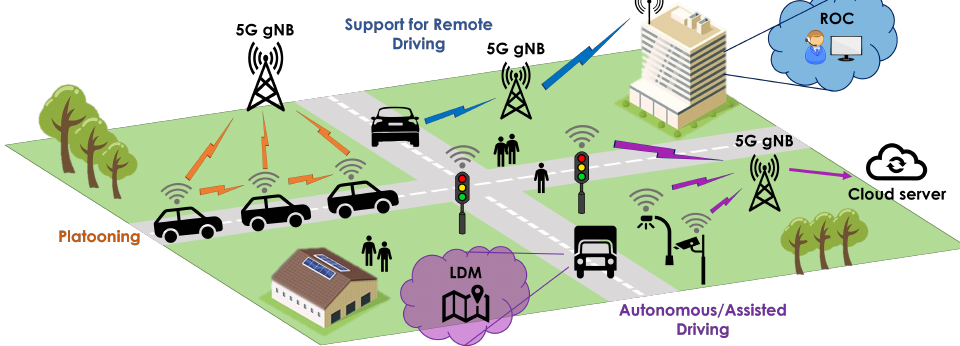
Figure 2. High-level overview of the advanced use cases expected to be supported by 5G